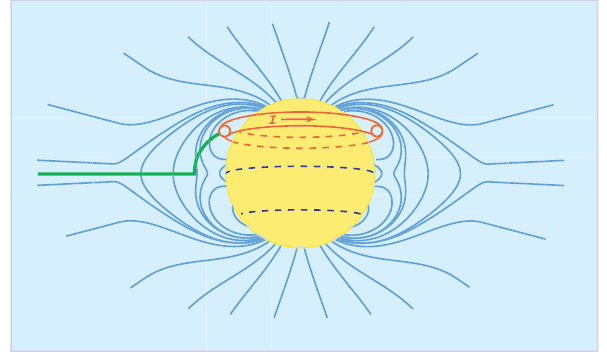
Fig. 6. Field lines of the solar global magnetic field typical for minimum activity adopted in the axially-symmetric flux rope model (Filippov et al., 2002). The dashed lines show the polarity inversion lines at the photospheric surface, and the green line, the possible equilibrium positions of the flux rope. Fig. 7. The observed filament height above the chromosphere h